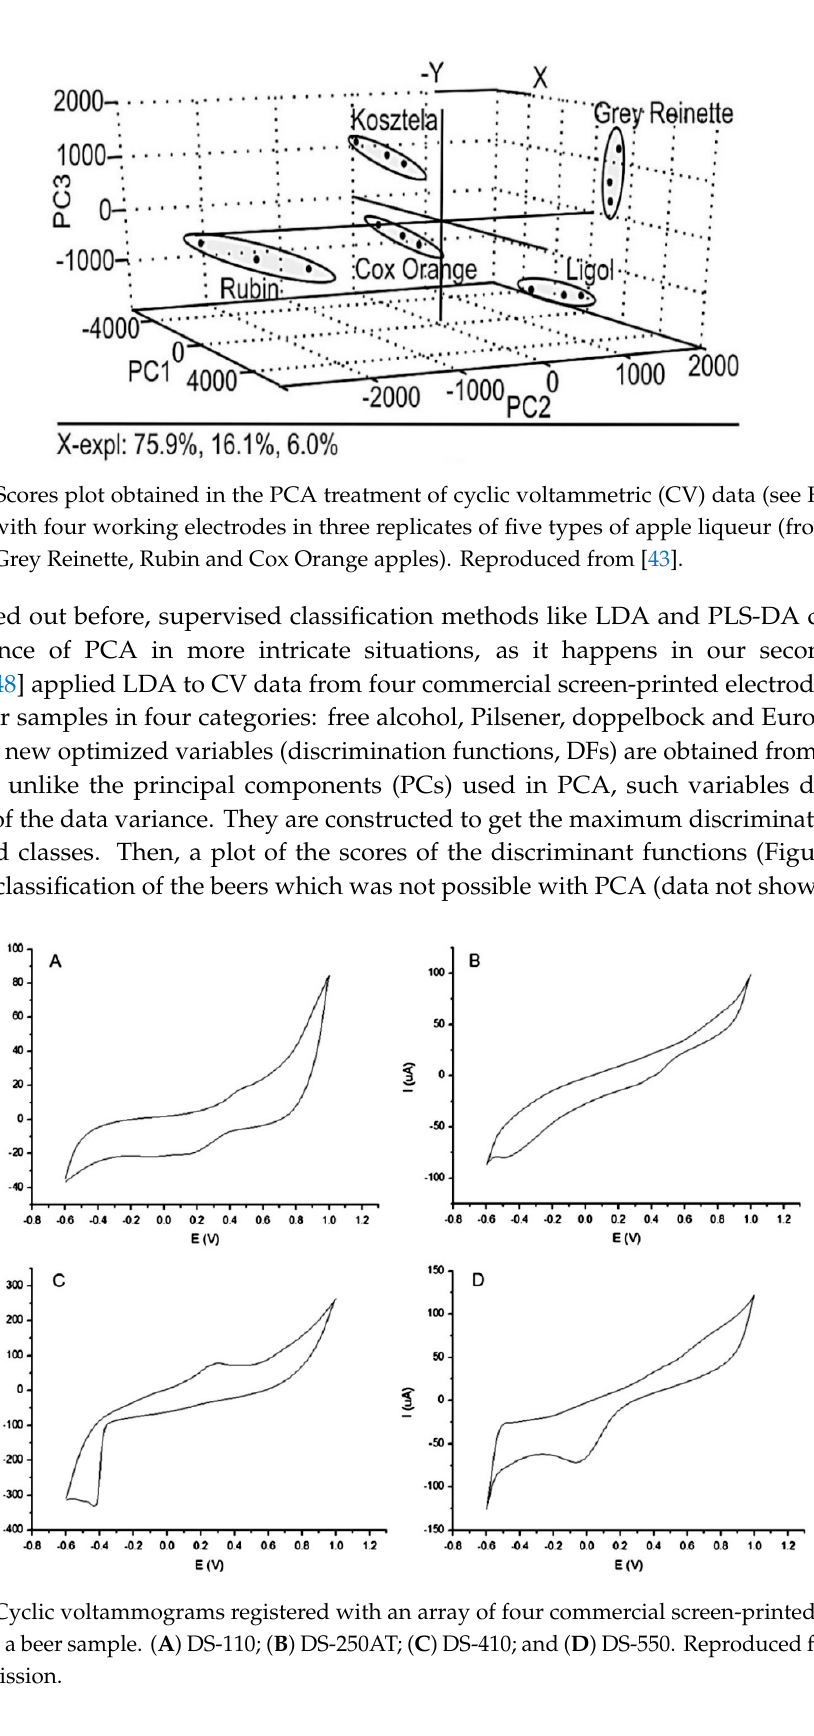
Figure 2. Cyclic voltammograms registered using four different carbon paste electrodes (CPEs) immersed in liqueur samples made from different varieties of apples. ( a ) Unmodified CPE; ( b ) ZnPc– CPE; ( c ) FePc–CPE; ( d ) CoPc–CPE. Apple varieties: Ligol (black), Kosztela (red), Grey Reinette (blue), Rubin (green), Cox Orange (purple). Reproduced from [43].